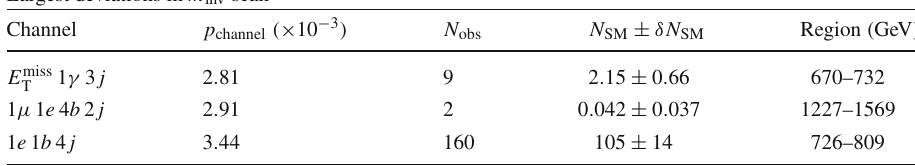
Table 5 List of the three channels with the smallest p channel -values in the scan of the m